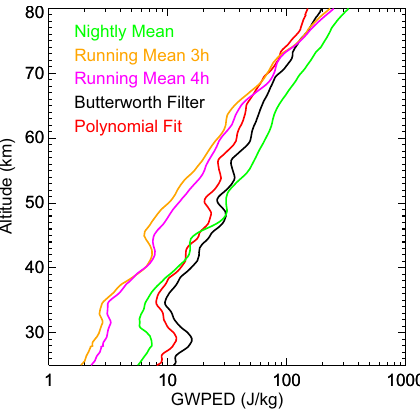
Figure 7. Mean gravity wave potential energy density (GWPED) per mass over Lauder, New Zealand, (45.0 ◦ S, 169.7 ◦ E) between 1 July and 30 September 2014. The methods used to determine the GWPED are color-coded. The profiles were smoothed by a vertical running mean with a window width of